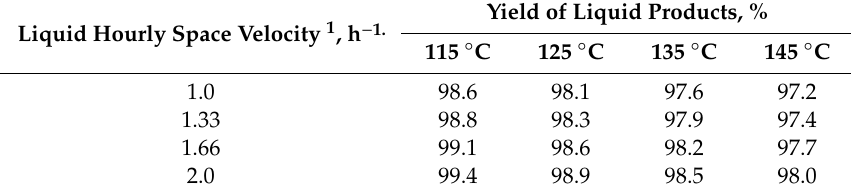
Table 4. Yield of the liquid products in the function of process parameters (catalyst: Pt/Al 2 O 3 /Cl, feedstock: “A”).